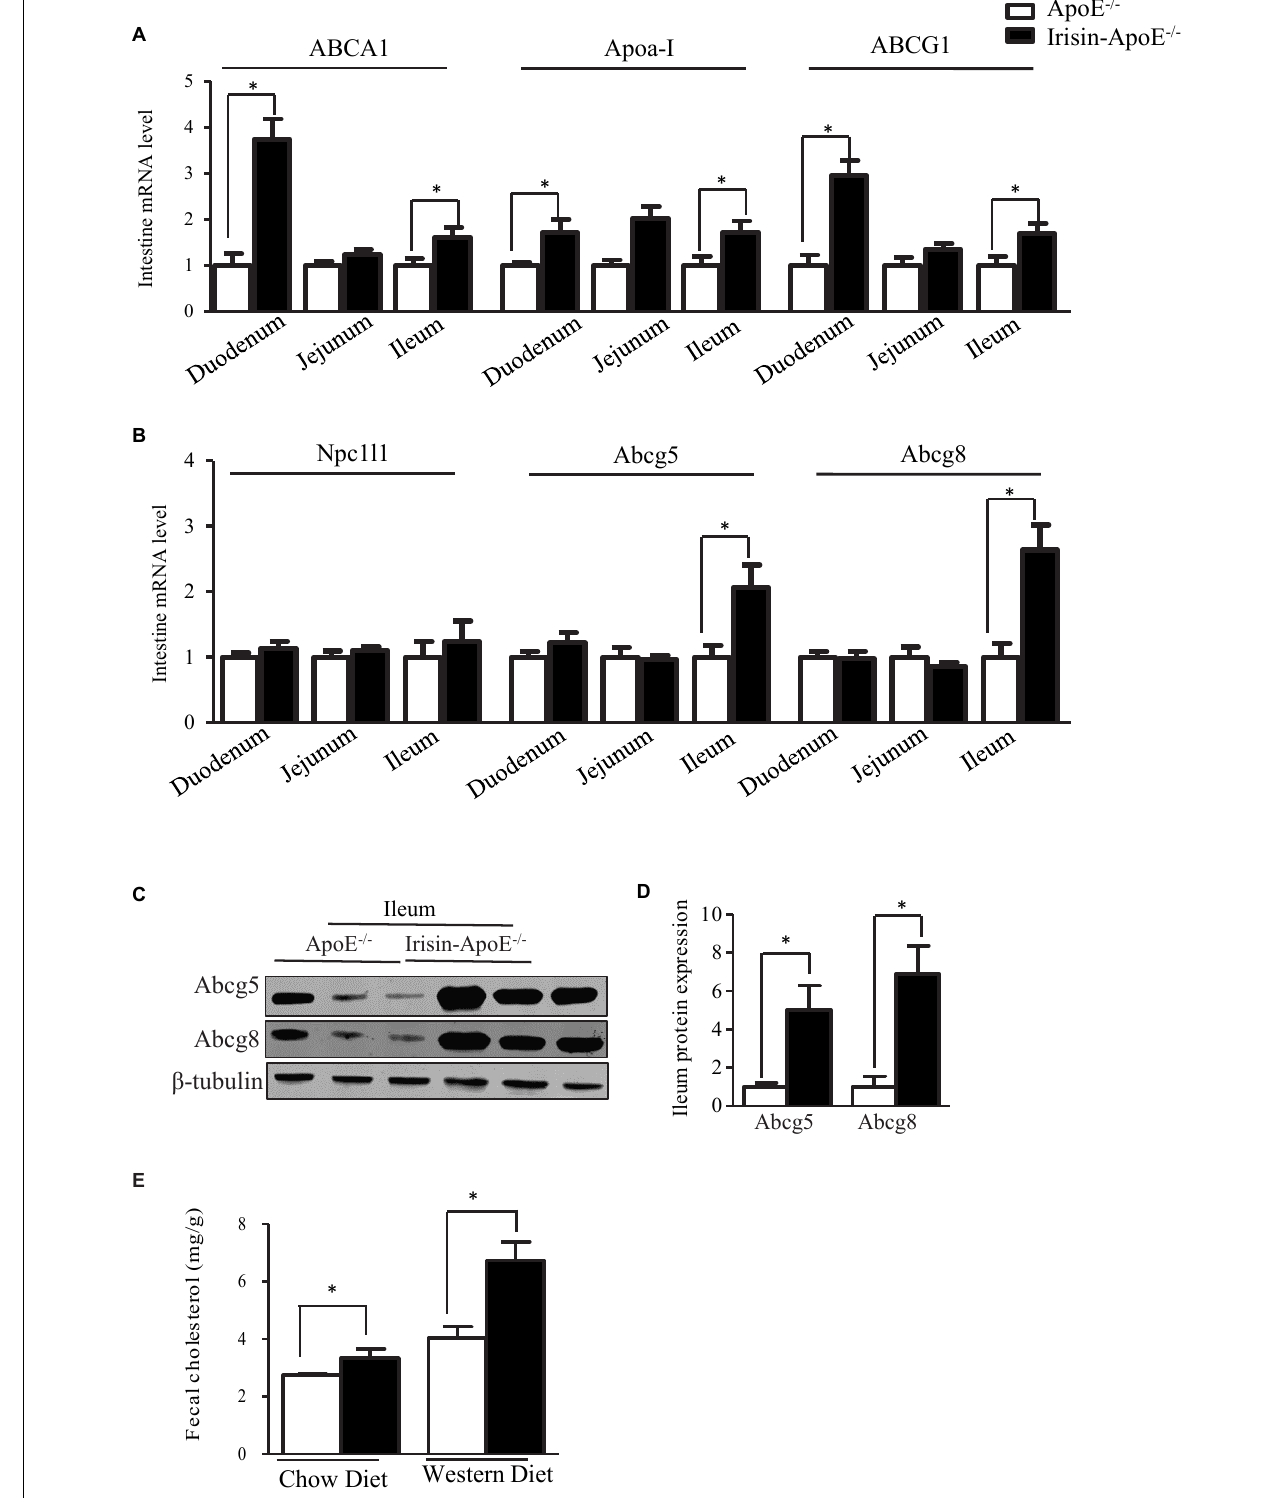
FIGURE 5 | Intestinal Abcg5 and Abcg8 levels were increased in Irisin-ApoE − / − mice. (A,B) mRNA expression of cholesterol transporters in duodenum, jejunum, and ileum of mice ( n = 6). (C,D) Protein expression of Abcg5 and Abcg8 in the ileum ( n = 3) and (E) fecal cholesterol output in mice ( n WT = 6, n TG = 4, n WTD - WT = 6, n WTD − TG = 6). Data are mean ± SEM. ∗ P < 0.05.